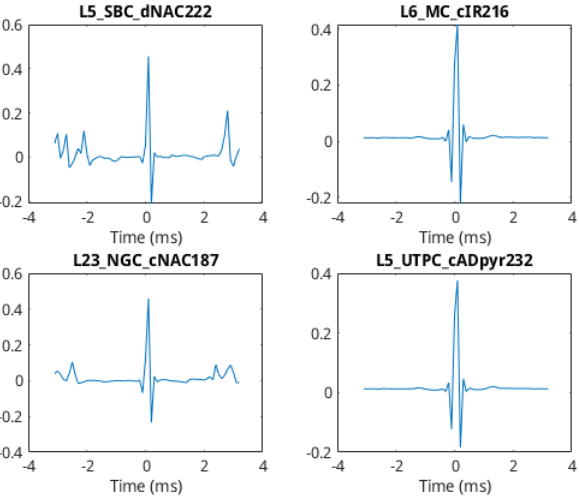
Figure 9. Sample impulse − response characterisation of different